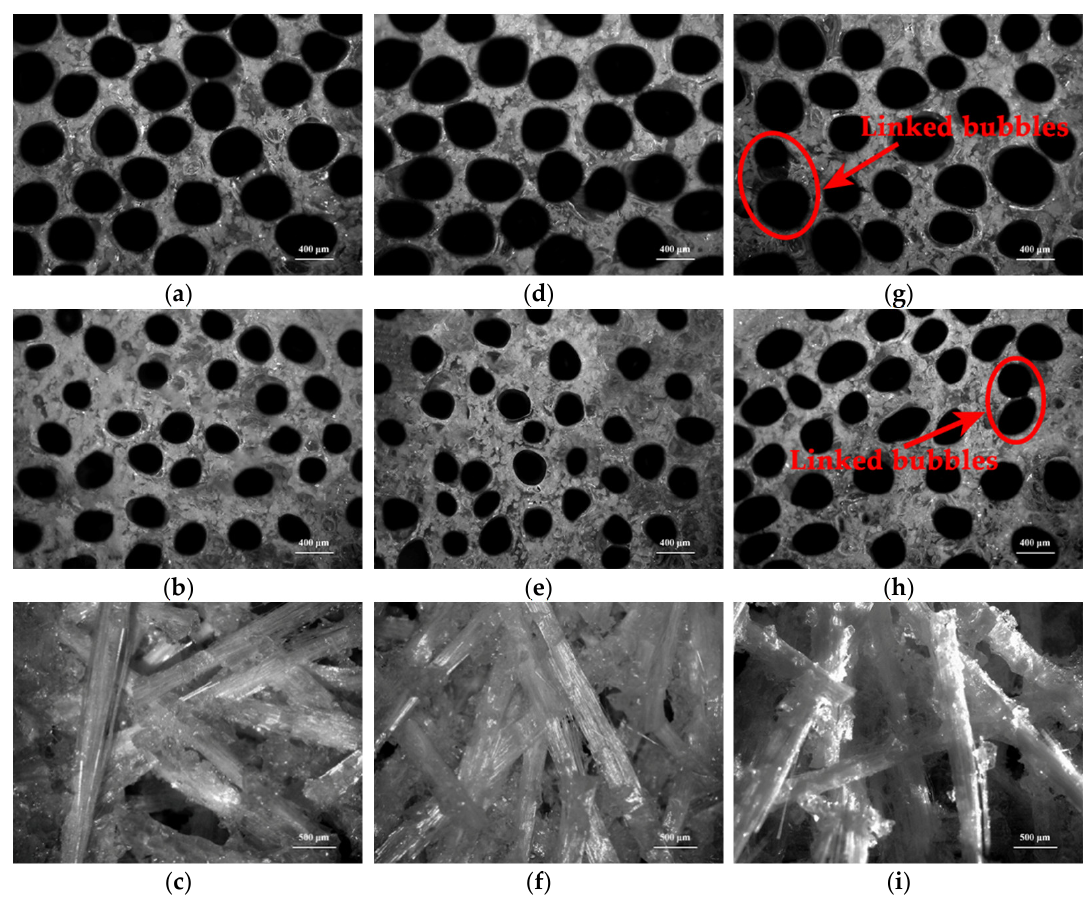
Figure 8. Micrographs of cured samples, with the coexistence of MEKP-II and cobalt naphthenate, ( a ) cured LDUPR sample, ( b , c ) cured LCGFR-LDUPR composite sample with the presence of 20.00 phr of long chopped glass fiber; with the coexistence of CYHP and cobalt naphthenate, ( d ) cured LDUPR sample, ( e , f ) cured LCGFR-LDUPR composite sample with the presence of 20.00 phr of long chopped glass fiber; with the coexistence of TBPO and cobalt naphthenate, ( g ) cured LDUPR sample, ( h , i ) cured LCGFR-LDUPR composite sample with the presence of 20.00 phr of long chopped glass fiber.